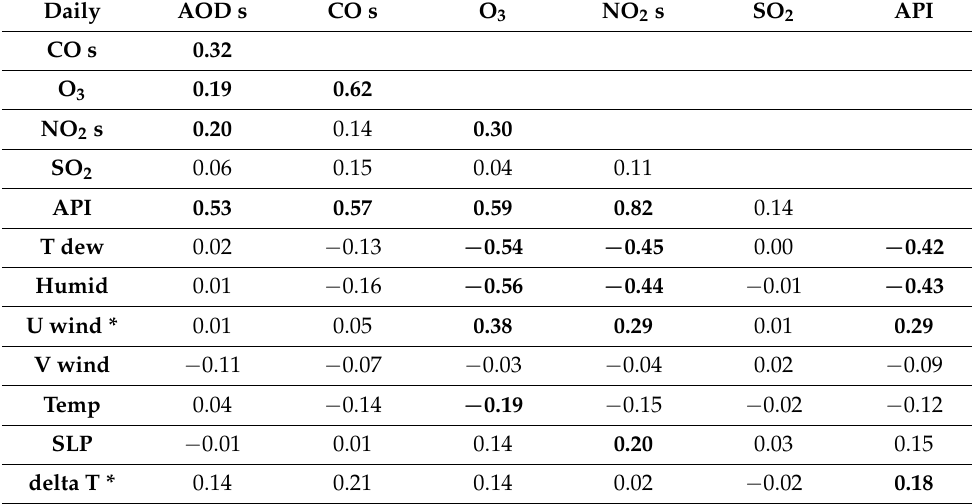
Table 3. Simultaneous pair-wise cross-correlation of surface air constituents and ERA5 1000–850 hPa meteorology variables over the Durban-area: daily (2005–2020 N =